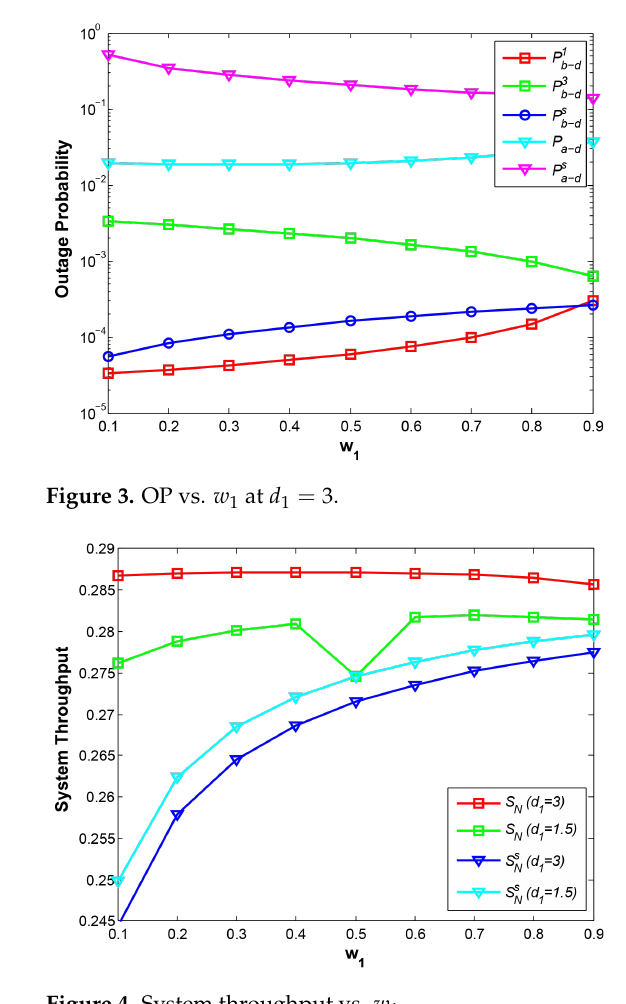
Figure 4. System throughput vs. w 1